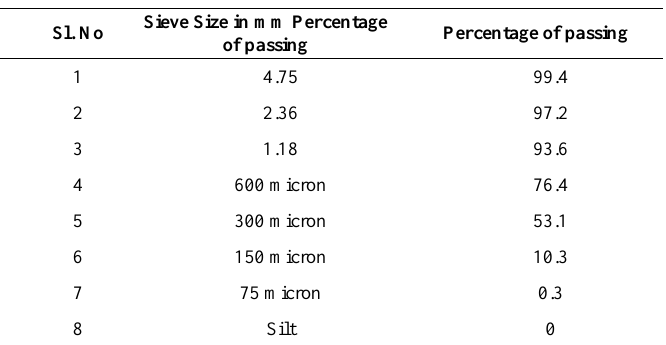
Table 3. Sieve Analysis.